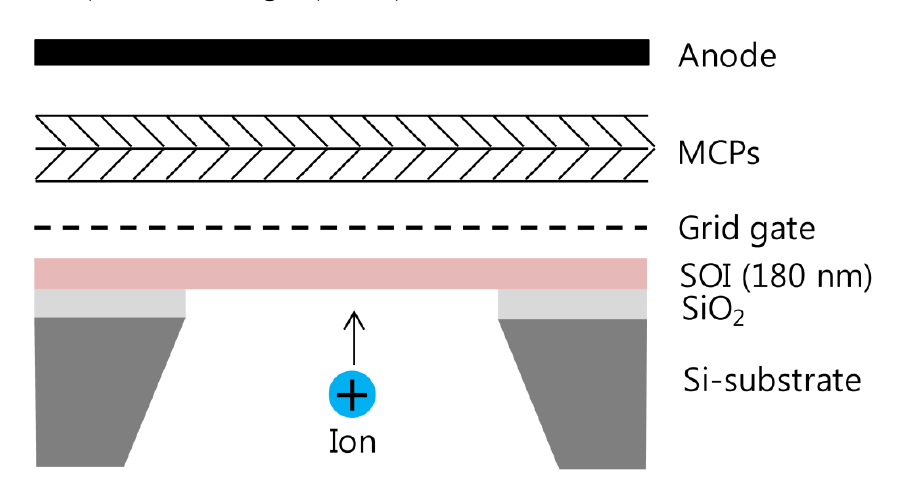
Figure 1. Schematic of the detector configuration, consisting of a 180 nm thick silicon nanomembrane, an extraction gate, MCP, and an